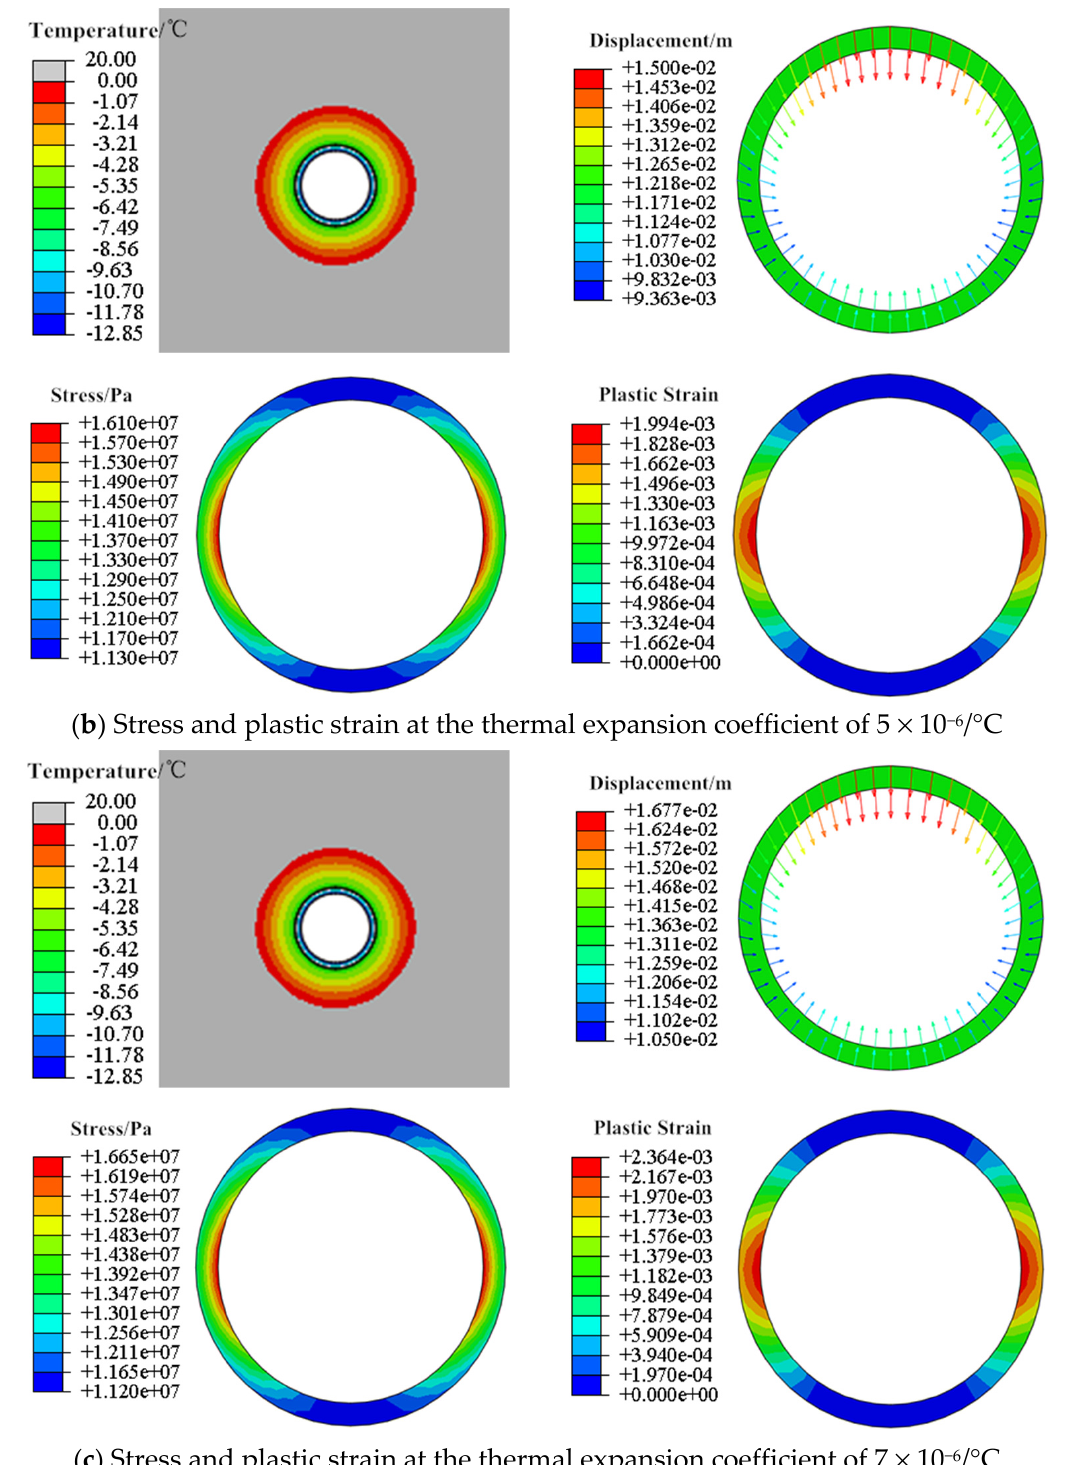
Figure 6. Influence of different thermal expansion coefficients on bearing characteristics. From Figures 5 and 6, when the temperature field is constant and the freezing depth does not change, the frost heave increases with the increase of the thermal expansion coefficient. It shows that the frost heave rate is proportional to the thermal expansion coefficient. The compressive stress at the arch waist of the support structure gradually increases from 15.59 MPa to 16.65 MPa with the increase of the thermal expansion